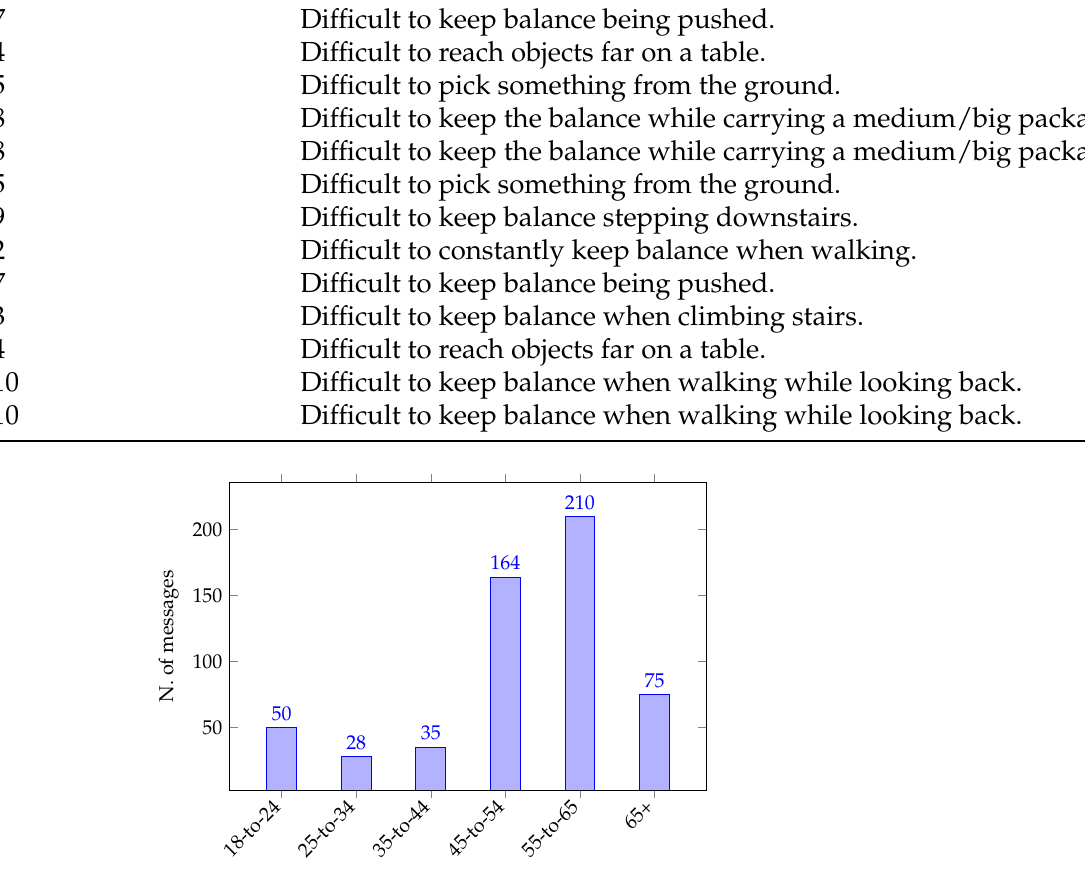
Figure 15. Average number of messages sent per participant within the age